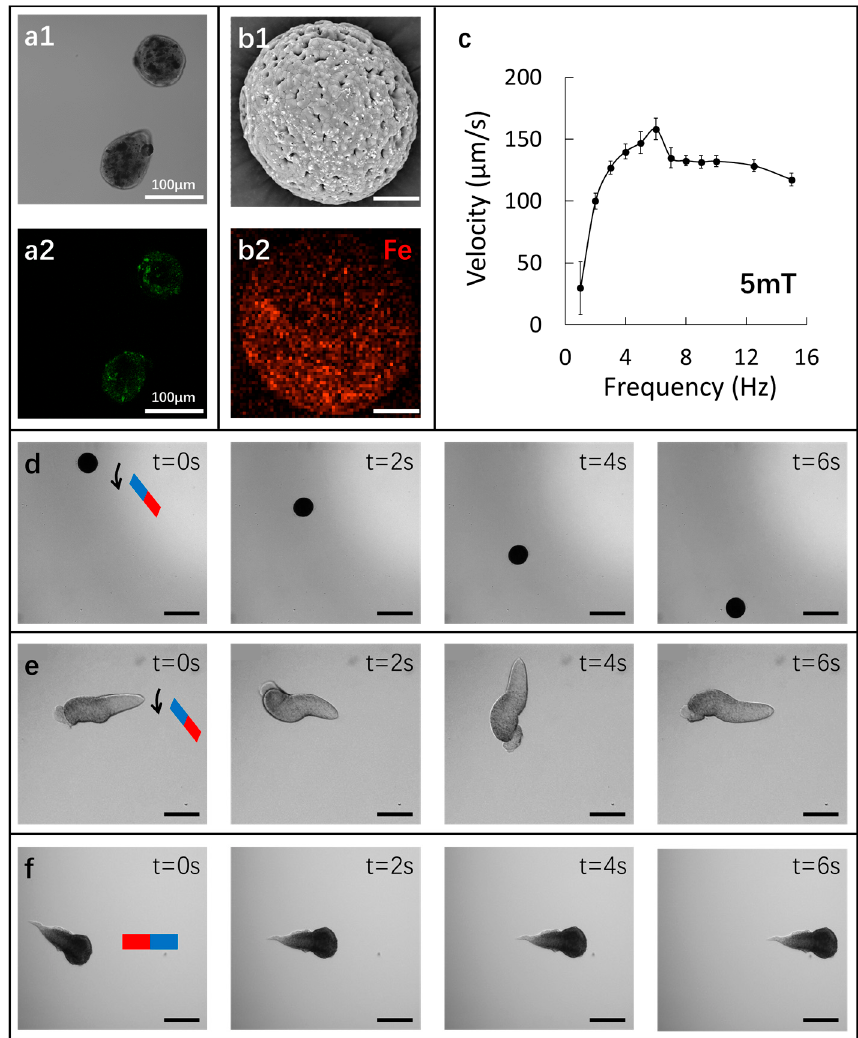
Figure 4. ( a1 ) Bright-field and ( a2 ) fluorescence microscopic image of micromotors with incorporated FITC-labeled Fe 3 O 4 nanoparticles. ( b1 ) SEM image and ( b2 ) corresponding EDX mapping analysis of a Ca-Alg/Fe 3 O 4 micromotor for iron (scale bar 20 µm). ( c ) Relationship between the advancing velocity of spherical micromotors (prepared with C i , Na - Alg at 9 mg/mL for the microfluidic experiment and C CaCl at 10 wt% for the gelation) and the frequency at 5 mT. Video snapshots (scale bar 200 µm) at different time intervals of a ( d ) spherical and ( e ) worm-like micromotor under the rotating magnetic field at 5 mT around X axis in Y-Z plane; ( f ) droplet-like micromotor under the X-axis magnetic field gradient of 3 T/m.